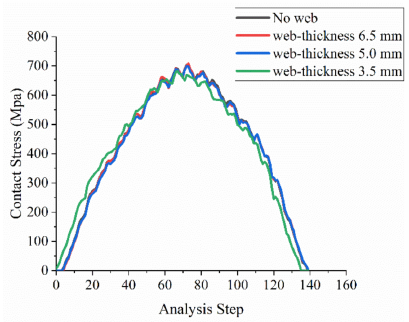
Figure 5. Contact stresses of models with different web